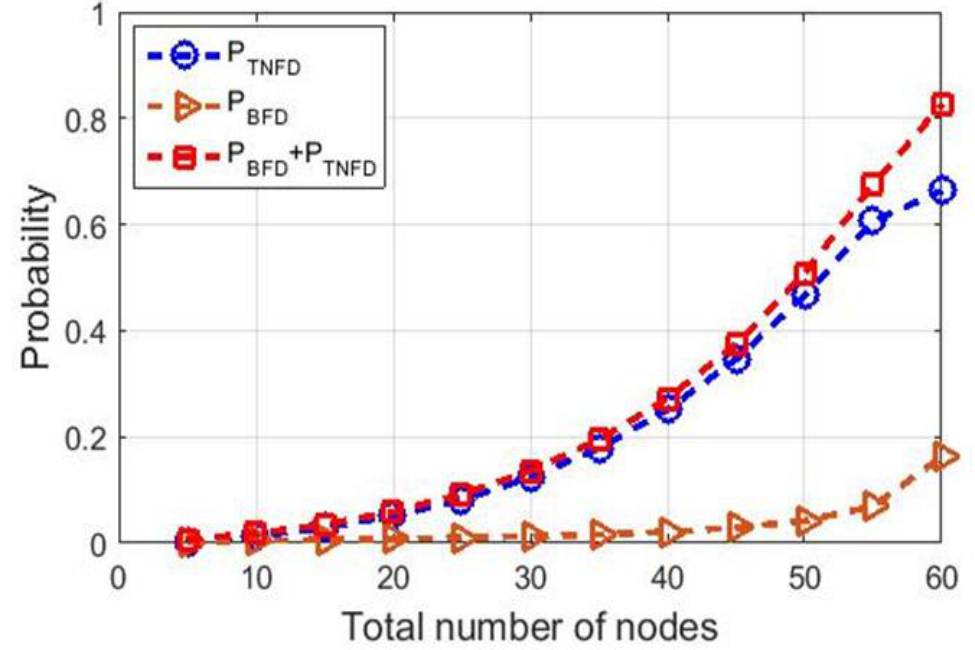
Figure 9. Probability for TNFD communications vs. total number of nodes.